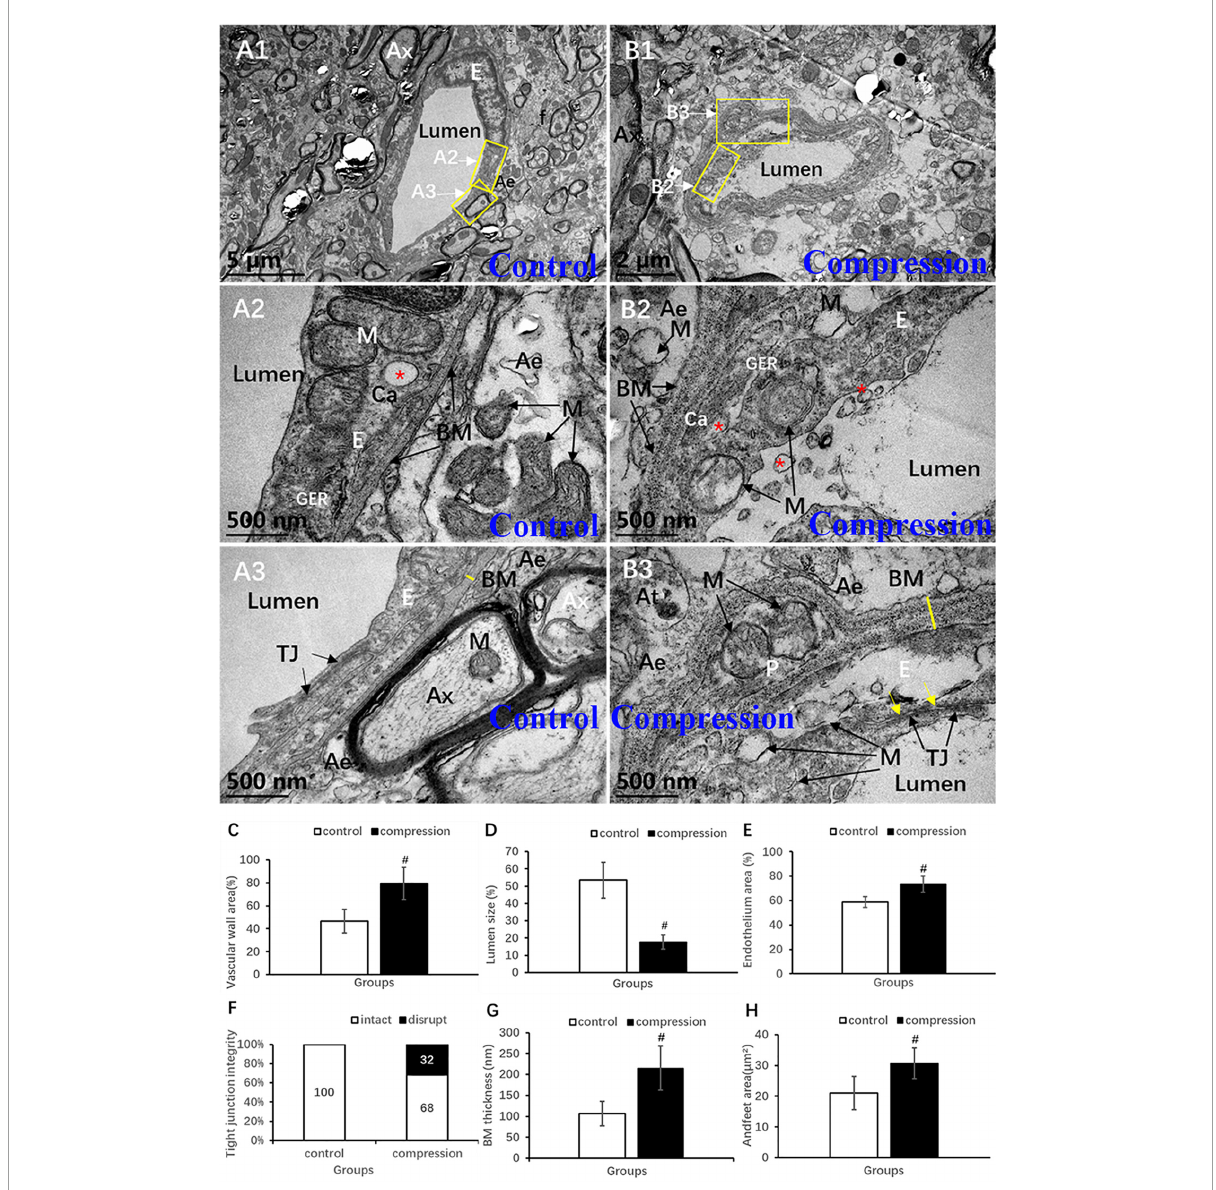
FIGURE8 Ultrastructural destruction of microvascular and vascular elements. (A1–A3) Normal ultrastructure of microvascular and vascular elements in the control group. (B1–B3) Ultrastructural destruction of microvascular and vascular elements in the CSM group. Comparison of characteristics between two groups: vascular wall area (C) , endothelium area (E) , Tj disruption (F) , BM thickness (G) , endfeet area (H) , and lumen size (D) . Ax, axon; E, endothelial cells; p, pericyte; BM, basal membrane; Tj, tight junction; M, mitochondria; Ae, astrocyte endfeet; f, filament; “*” Ca, caveolae; yellow arrow indicates disruption of interacting plasm membranes of Tj; “#” significant difference between CSM and control group ( P < 0.05, n = 6 per